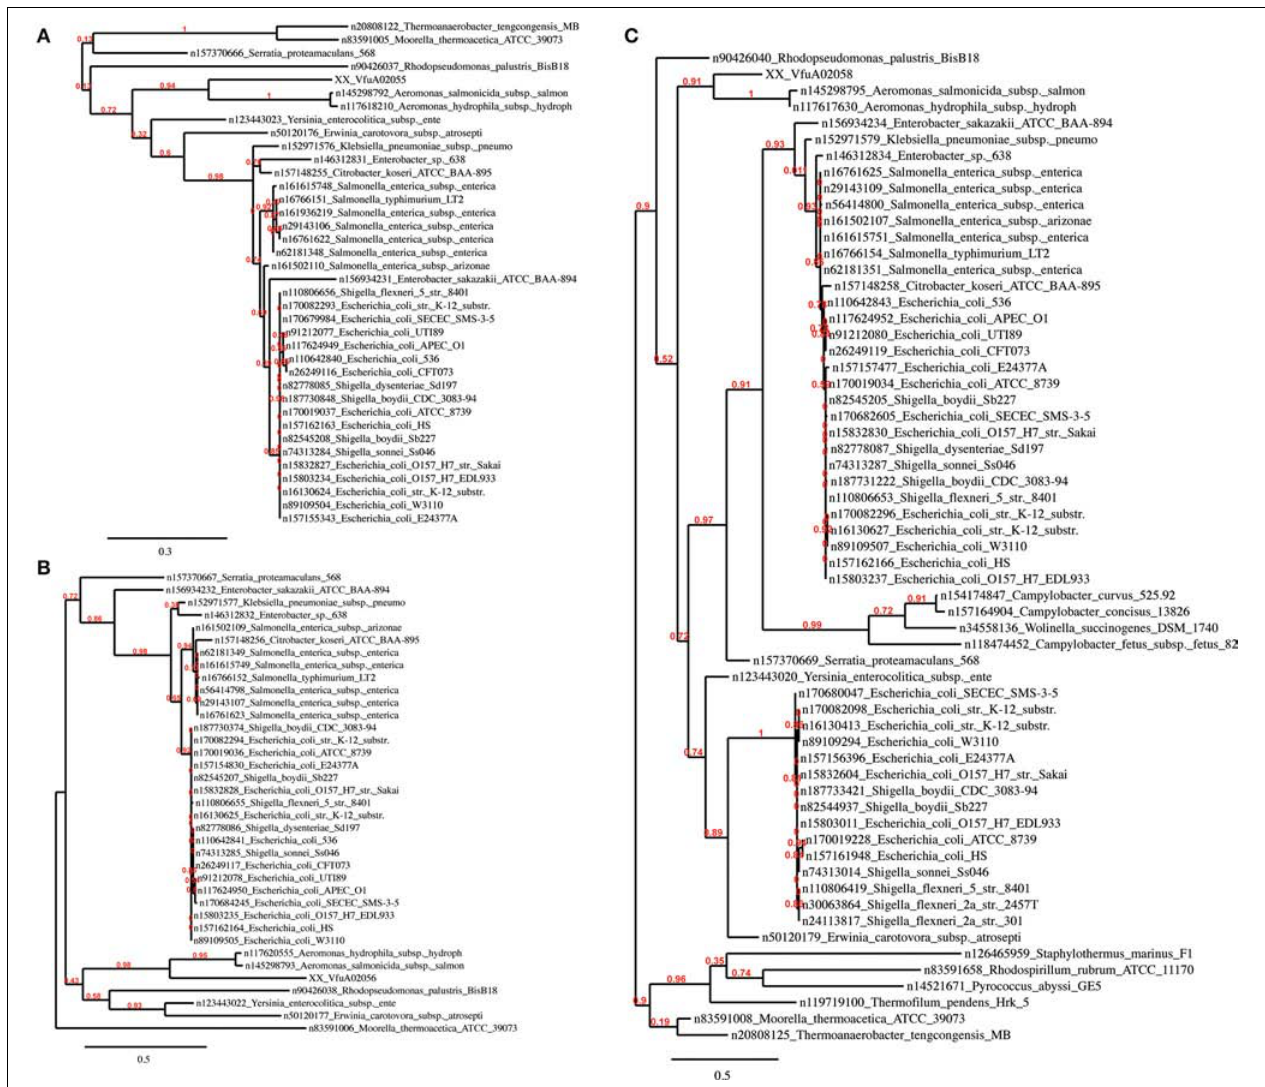
FIGURE 4 | Phylogenetic trees of the V. furnissii proteins (A) VfuA02055, (B) VfuA02056, and (C) VfuA02058 showing their homology to Aeromonas salmonicida . Numbers representing branch support